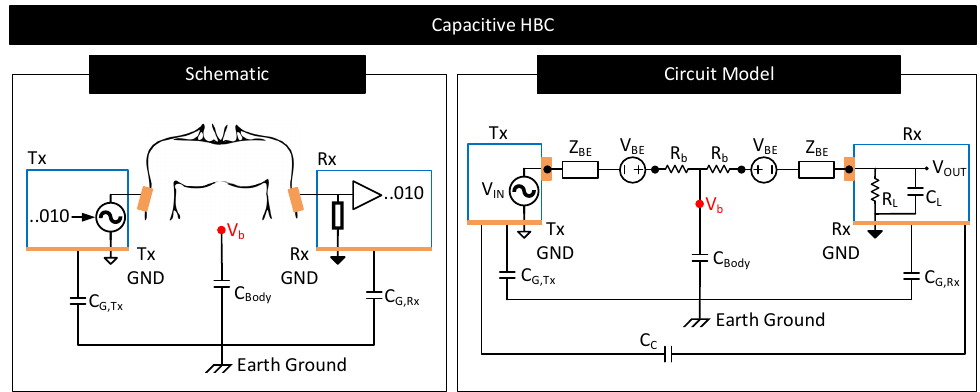
Figure 18. Simplified schematic and circuit model of capacitive HBC. Circuit elements V BE and Z BE model the contact potential and impedance of the body–electrode interface. Circuit element R b models the resistance of the conductive core of the body. Circuit element C C represents the inter- device coupling capacitance between the ground electrodes of Tx and Rx [107]. Parallel combination of resistance, R L , and capacitance, C L , model the termination impedance